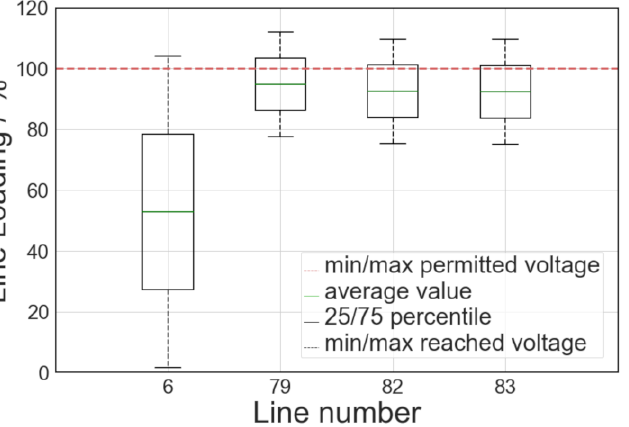
Figure 8. Line loading on some lines of the MV grid after optimizing the voltage setpoint of the HV/MV transformer.